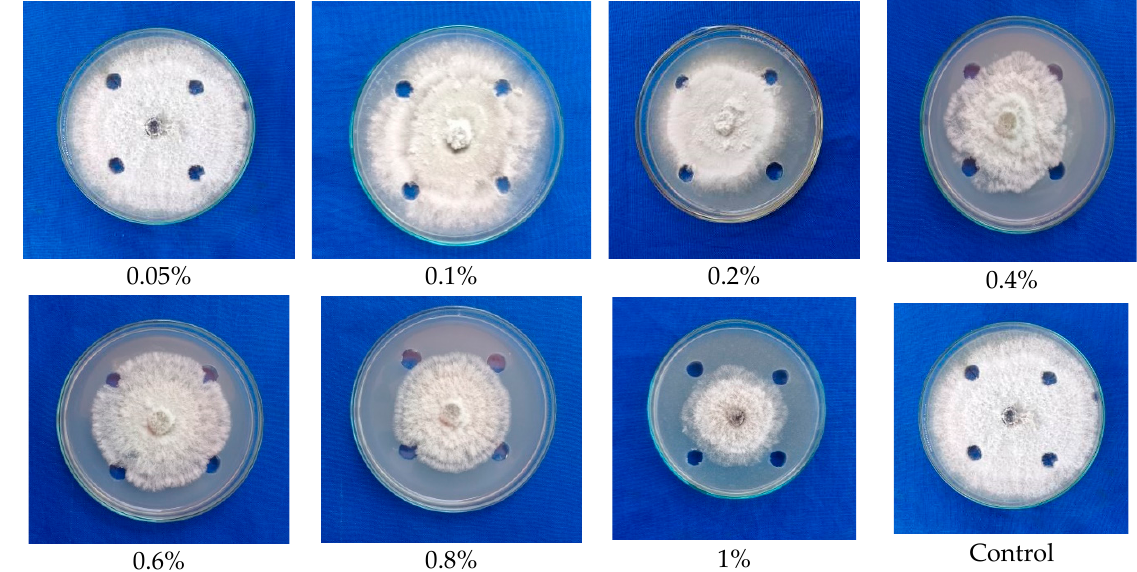
* Values are the mean of three replications. Means followed by a common letter are not significantly different at the 5% level by DMRT (Numerical letter indicated on percent inhibit represent the least inhibition of pathogen). Values in parenthesis are arcsine-transformed values.